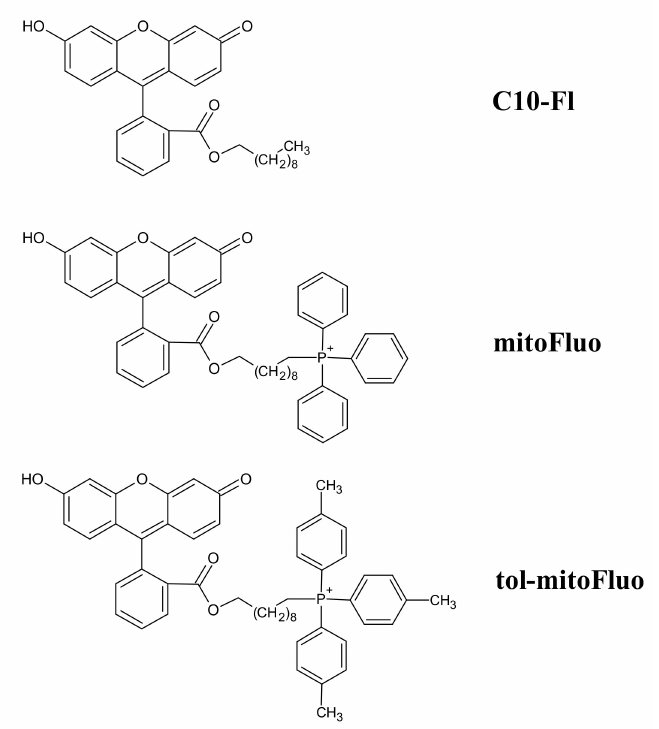
Figure 1. The chemical structures of tol-mitoFluo (fluorescein decyl(tri-p-tolyl)phosphonium ester), mitoFluo (fluorescein decyl(triphenyl)phosphonium ester), and C10-FL (fluorescein decyl